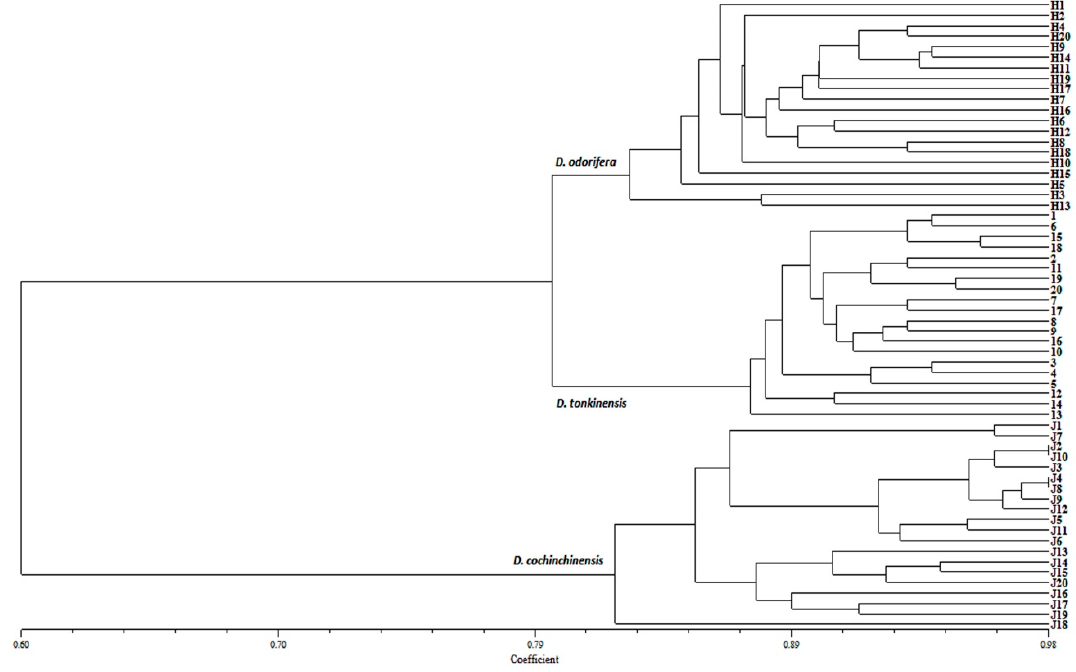
Figure 3. The UPGMA (un-weighted pair group method with arithmetic mean) cluster diagram of 60 Dalbergia trees based on the 19 newly developed SSR markers.